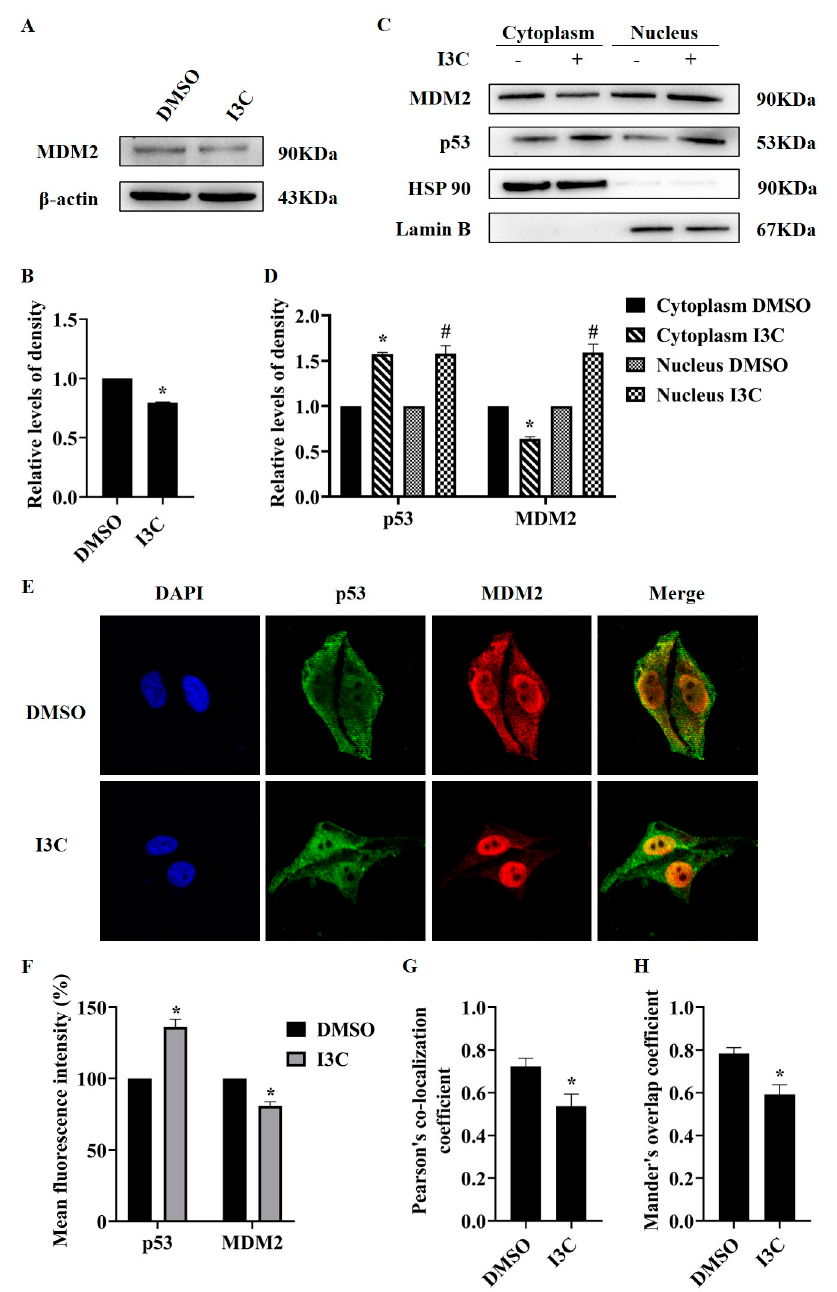
Figure 6. The effects of I3C treatment on MDM2 and p53. ( A ) The effect of I3C treatment on MDM2 expression; ( B ) Densitometric analysis for blots shown in ( A ). * p < 0.05 vs. DMSO; ( C ) Effect of I3C treatment on the protein levels of MDM2 and p53 in the nucleus and cytoplasm. Lamin B as a loading control for nuclear fraction and HSP90 for cytoplasmic fraction; ( D ) Densitomet- ric analysis for blots shown in ( C ). * p < 0.05 vs. Cytoplasm DMSO, # p < 0.05 vs. Nucleus DMSO; ( E ) The subcellular localization of MDM2 and p53 with immunofluorescence staining ( × 40); ( F ) Analysis of the mean intensity of immunofluorescence; ( G ) Pearson’s correlation coefficiency analysis; ( H ) Manders’ Colocalization Coefficiency analysis. * p < 0.05 vs.